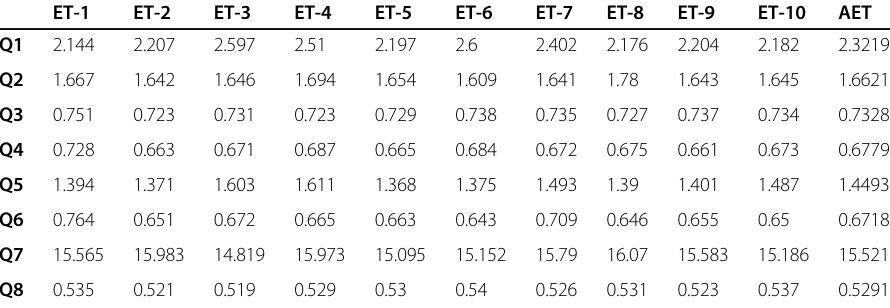
Table 9 Query execution time for Amazon RDS with Washington State data for